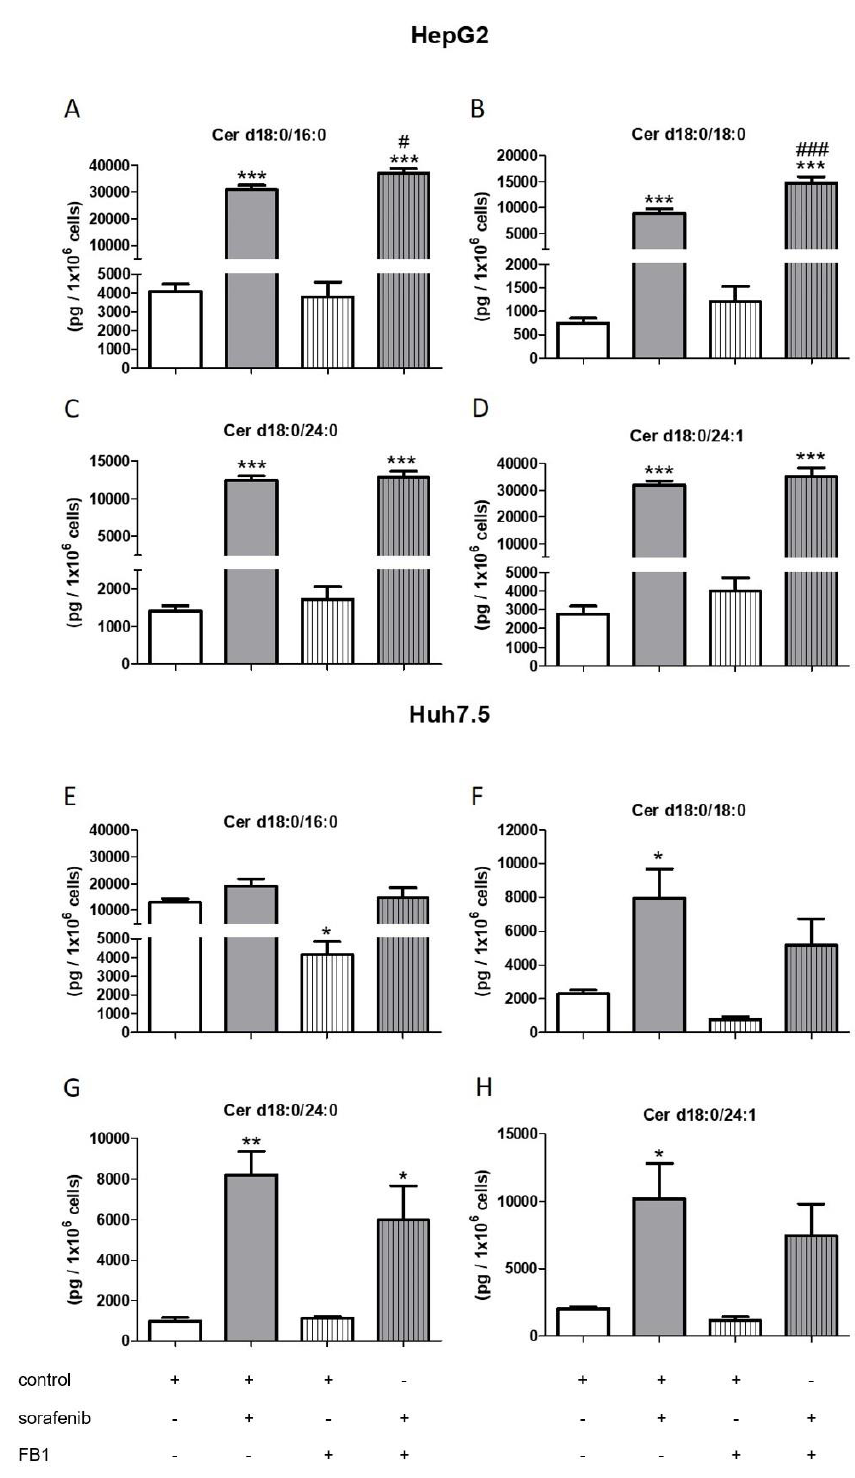
Figure 4. Influence of sorafenib and FB1 on concentrations of dihydroceramides in HepG2 and Huh7.5 cells. The lipids were measured by LC-MS / MS. The cells (HepG2 in ( A )–( D ) and Huh7.5 in ( E )–( H )) were treated with or without 25 µ M FB1 for 1 h before addition of vehicle (control; 0.2% DMSO) or 5 µ M sorafenib and further incubation for 24 h. All results are presented as the means ± SEM of 3–6 independent experiments. * p < 0.05, ** p < 0.01, *** p < 0.001 compared to control; # p < 0.05, ## p < 0.01, ### p < 0.001 compared to sorafenib in one-way ANOVA followed by Bonferroni post-tests.